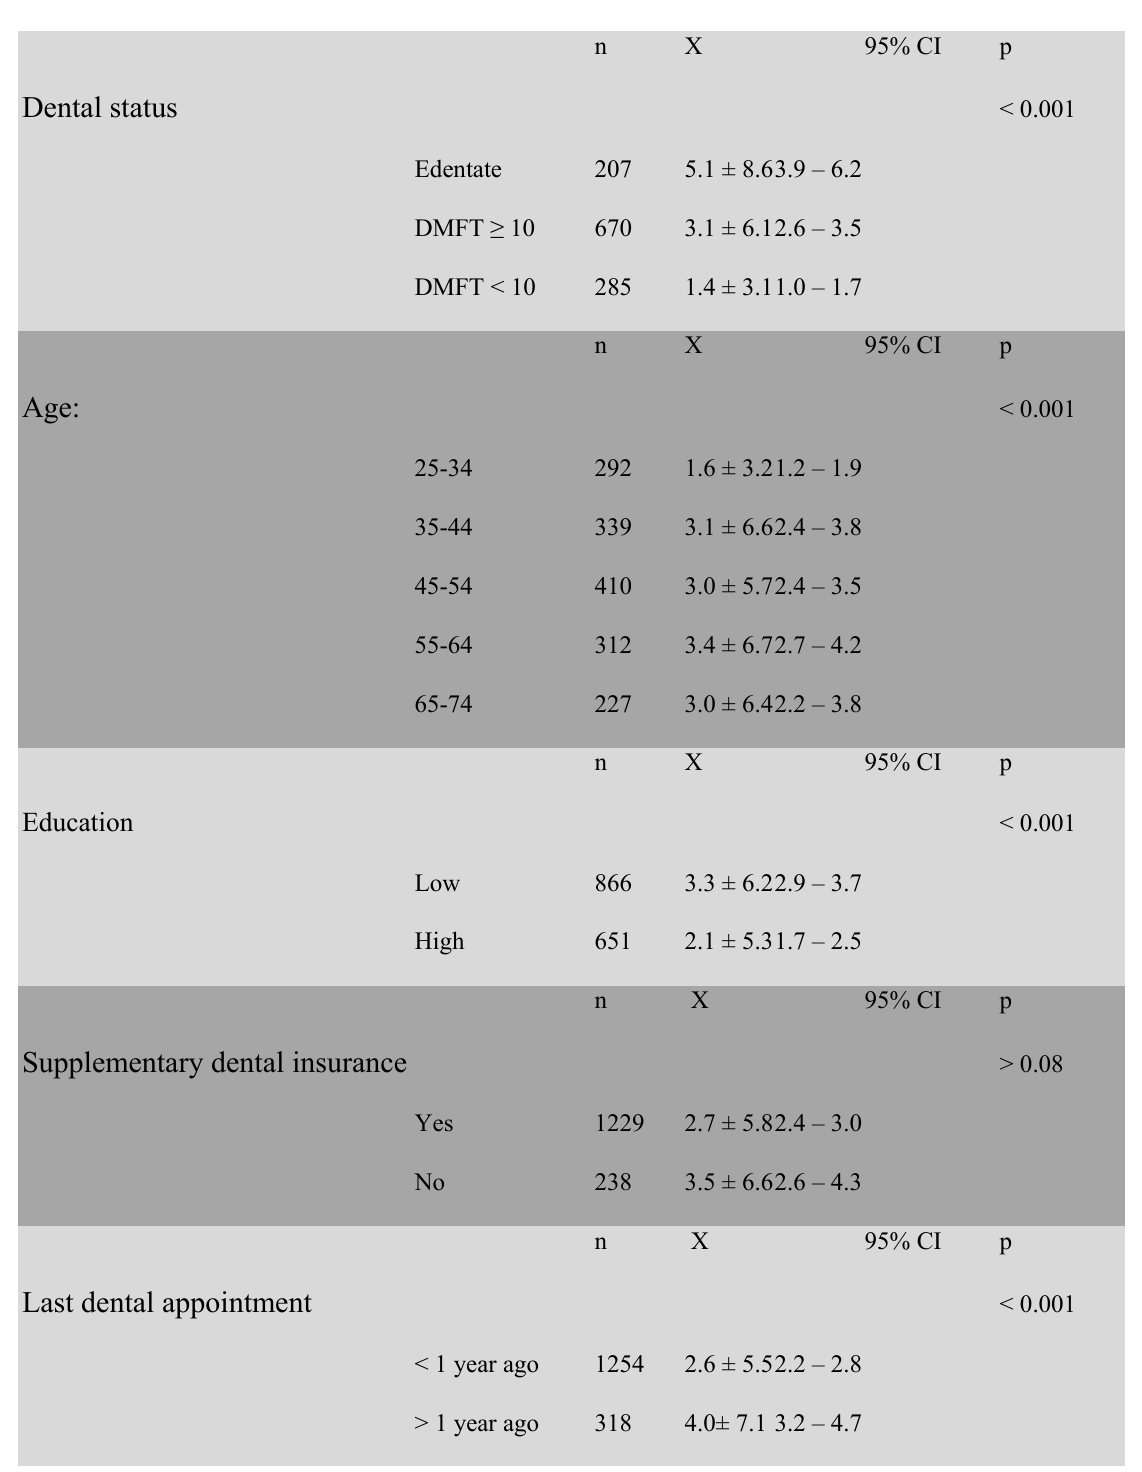
Table 1. Lists of all available data relating to the study variables. Number of respondents with data available (n), average OHIP-NL14 value with standard deviation (X), 95% confidence interval (95% CI) and p value for ANOVA (p) for each study